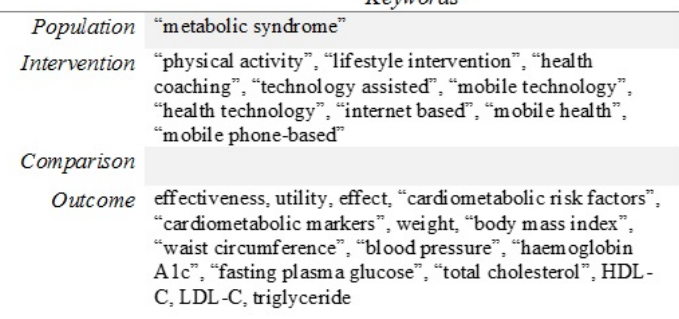
Figure 1. PICO (population, intervention, comparison, and outcome) search